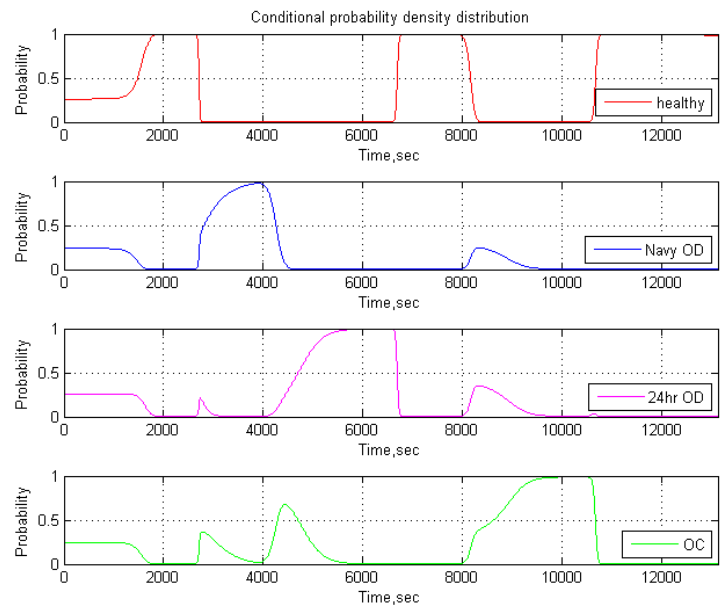
Figure 10. Conditional probability densities of respective battery operating conditions for R = 1 × 10 − 5 . For R = 1 × 10 − 8 , the conditional probability distribution provided by the MMAE algorithm are shown in Figure 11.